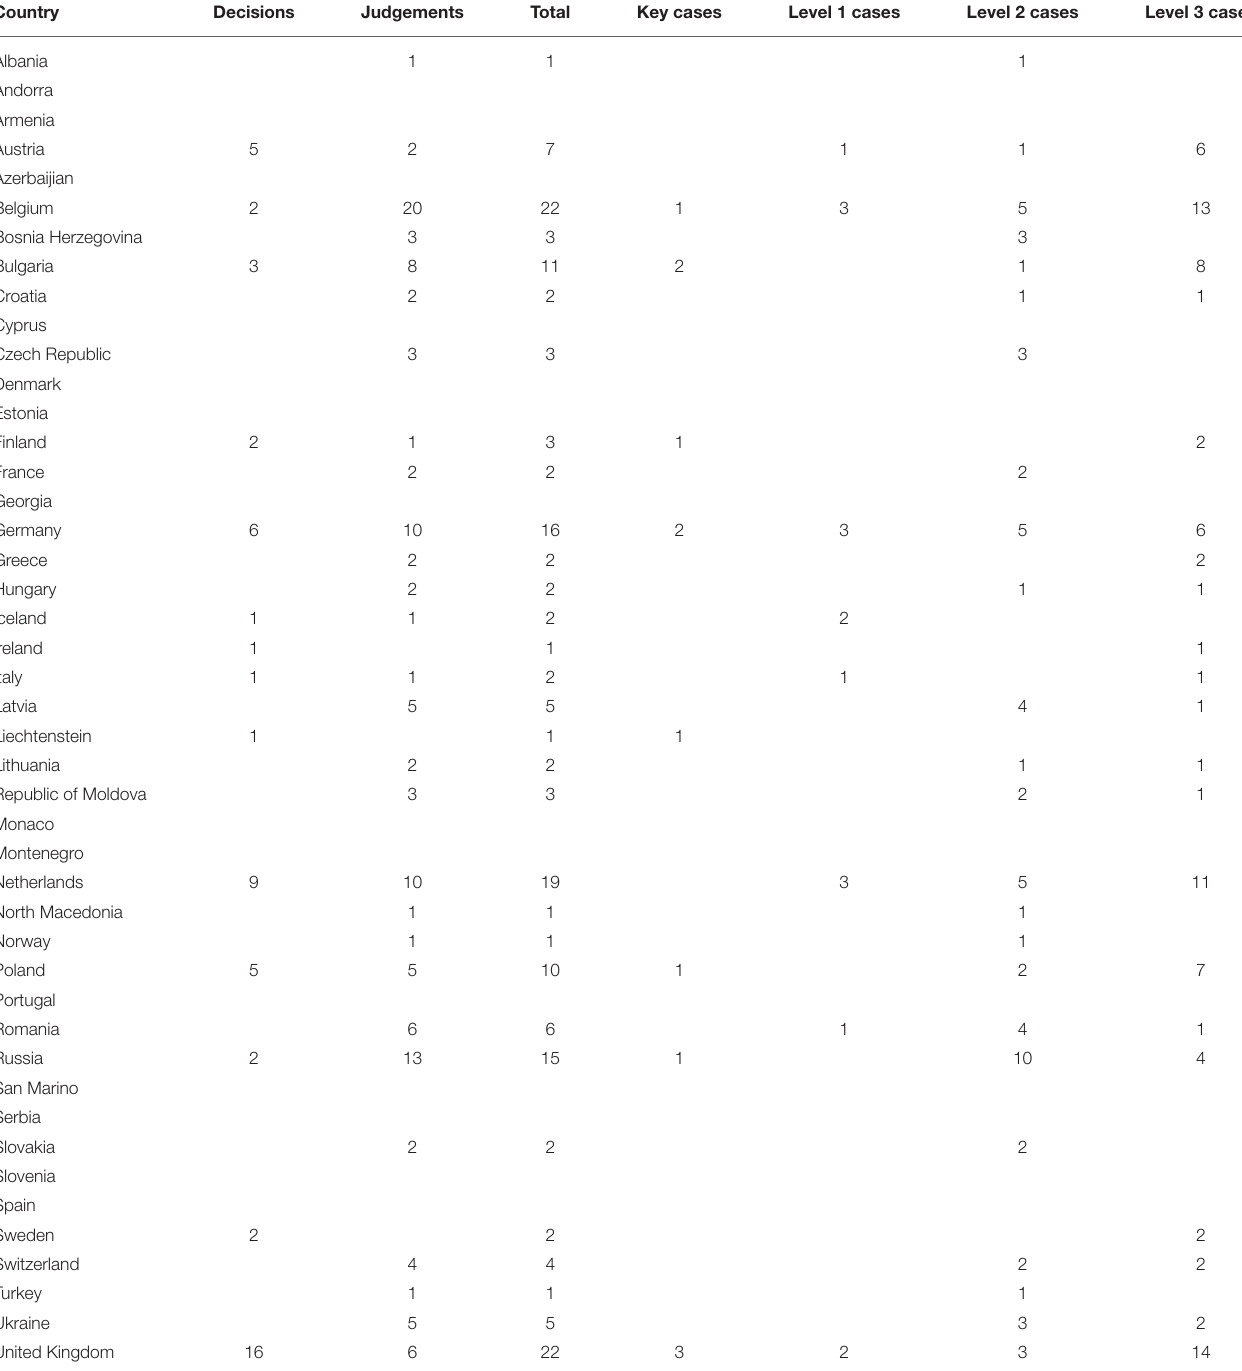
TABLE 1 | ECtHR judgements and decisions by country and by level of importance. Country Decisions Judgements Total Key